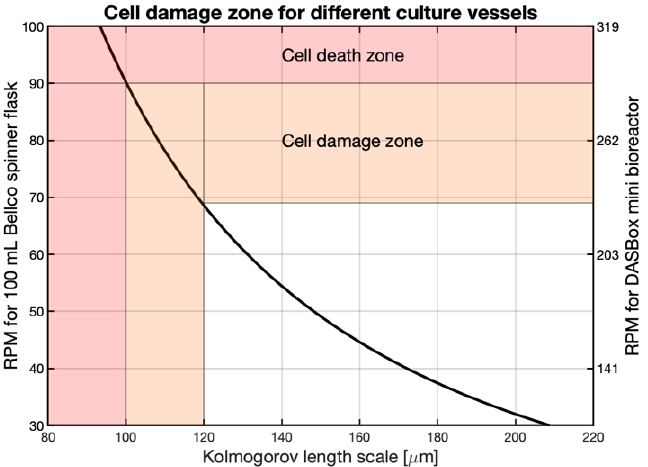
Figure 3. The Kolmogorov eddy length (x-axis) is represented as a function of the agitation speed in the Bellco spinner flask, left y-axis, and in the DASBox bioreactor, right y-axis, where the length scale associated with cell damage is marked in orange and the area associated with rapid cell death in red.